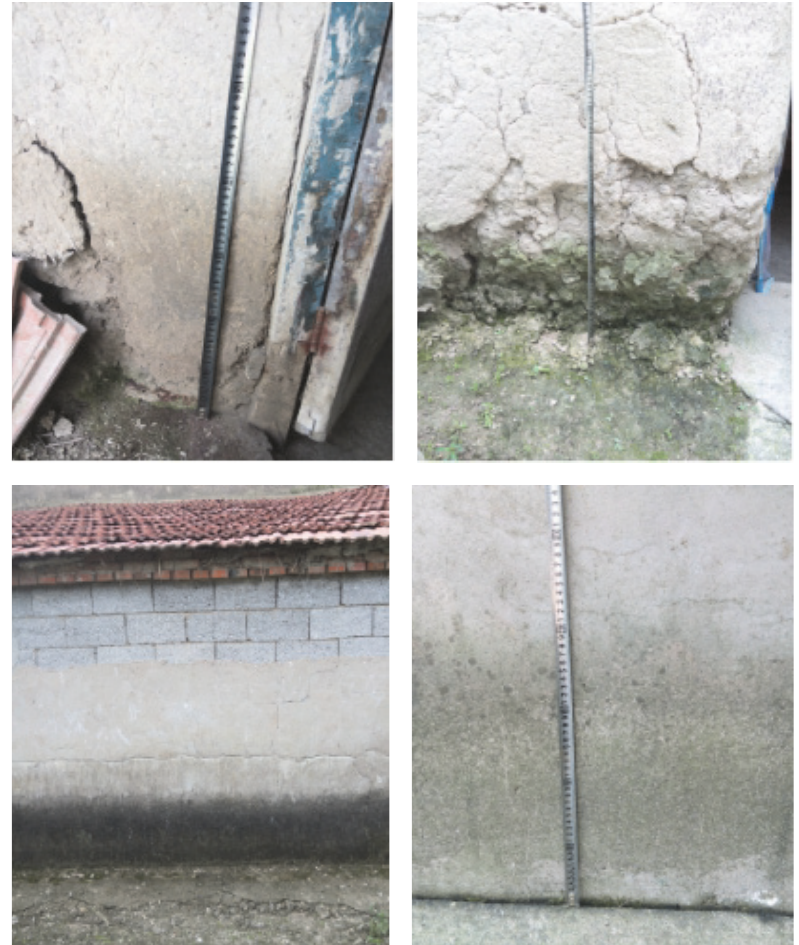
Figure 10: Photos showing immersion of residential buildings in the Qigang and Xiaomiaochen.